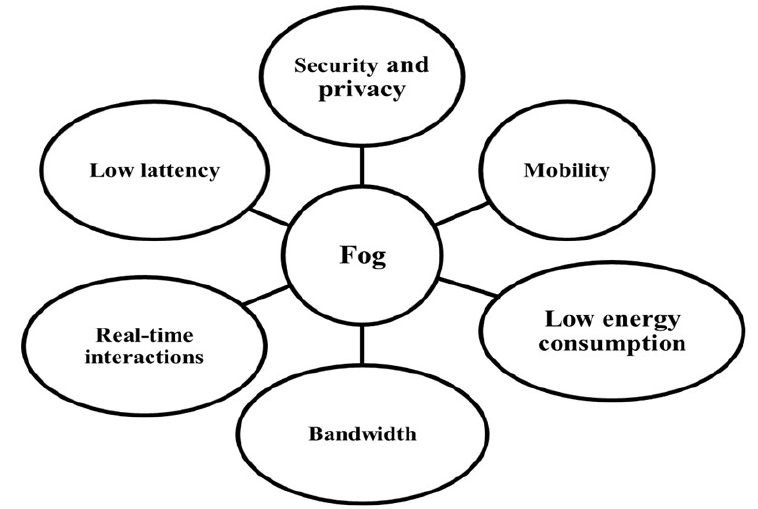
Figure 2. Main benefits of deploying fog computing for uRLLC applications.